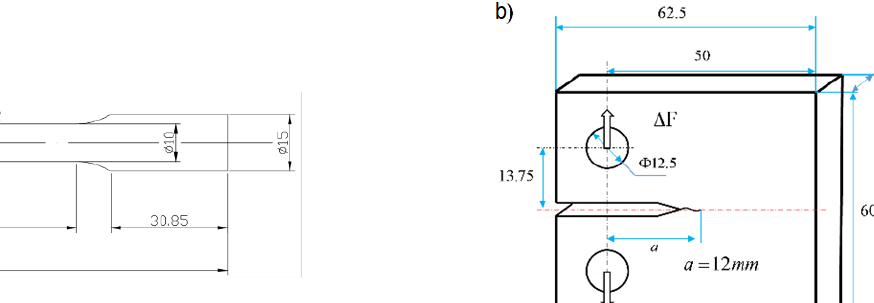
Figure 12. The fitting results of the Manson - Coffin and the Walker equations [54]. ( a ) The data fit for the Man- son - Coffin equation; ( b ) The data fit well for the Walker equation.